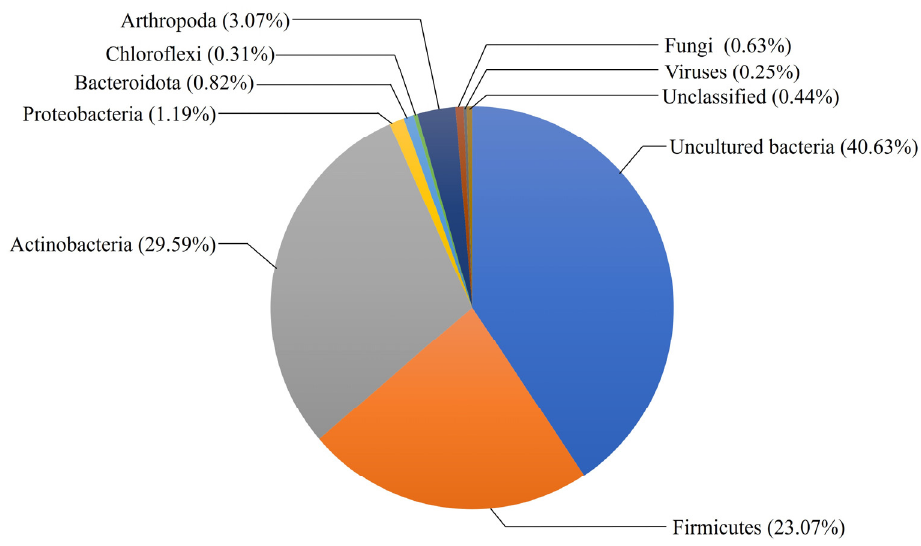
Figure 1. Distribution of GH48 sequences retrieved from the CAZy database.